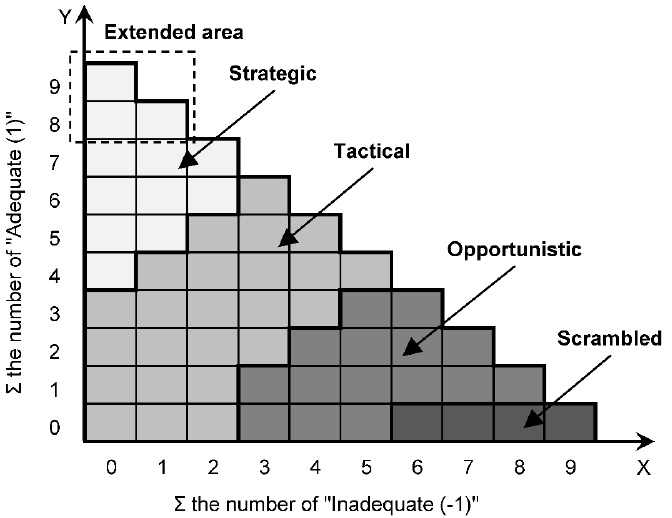
Figure 6. The relations between the common performance condition indicators (CPCs) and the CO- COMs.